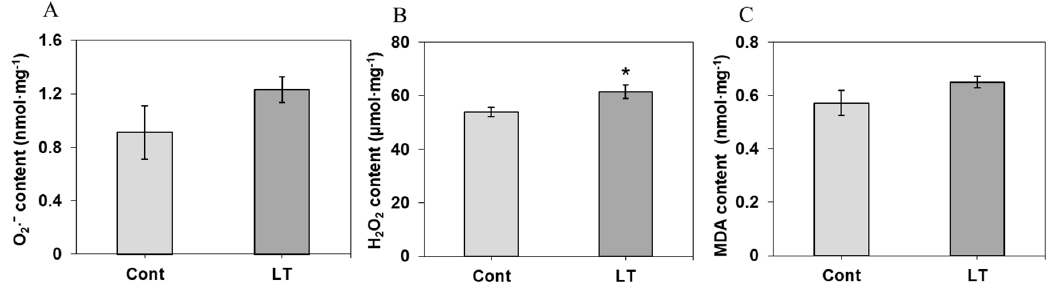
Figure 6. O 2 · ˉ content, H 2 O 2 content, and MDA content under low temperature and control conditions in wucai leaves. The contents of O 2 ˉ ( A ), H 2 O 2 ( B ) and MDA (Malondialdehyde) ( C ) are shown. * represents significant at P < 0.05 , ** represents significant at P < 0.01 .